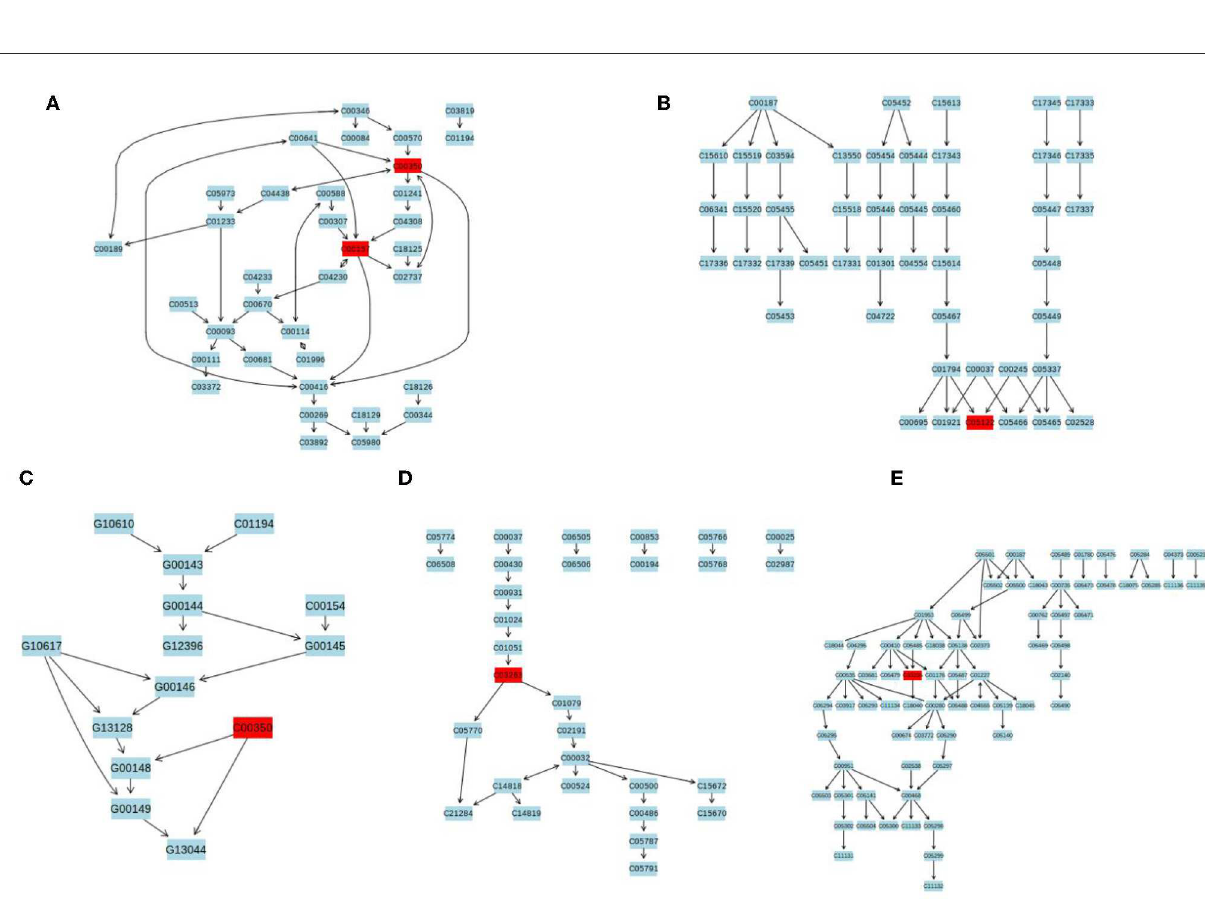
FIGURE4 The representative schematic diagram of liver metabolic exposed to thiram. (A) Glycerophospholipid metabolism. (B) Primary bile acid biosynthesis. (C) Glycosylphosphatidylinositol (GPI)-anchor biosynthesis. (D) Porphyrin and chlorophyll metabolism. (E) Steroid hormone biosynthesis. The red boxes represent the differential metabolites associated with thiram